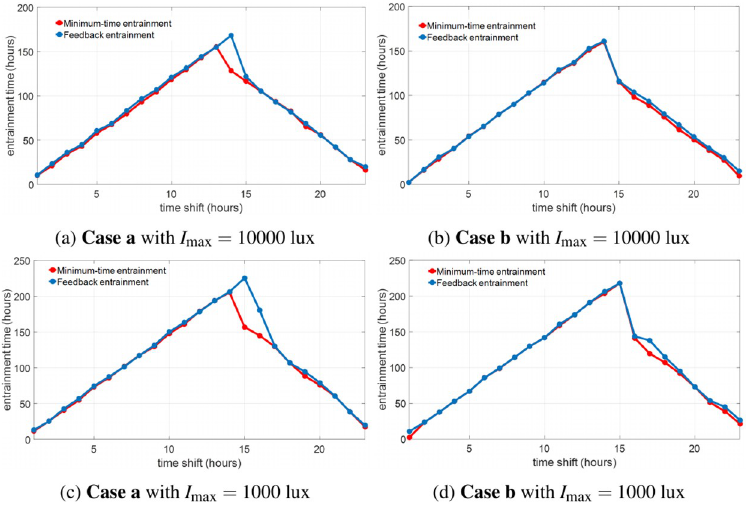
Fig 11. Comparison of the minimum-time (red) and feedback entrainment (blue) time on the cross-validation entrainment cases. We can observe that, in most cases, the feedback entrainment time is close or equal to the minimum entrainment